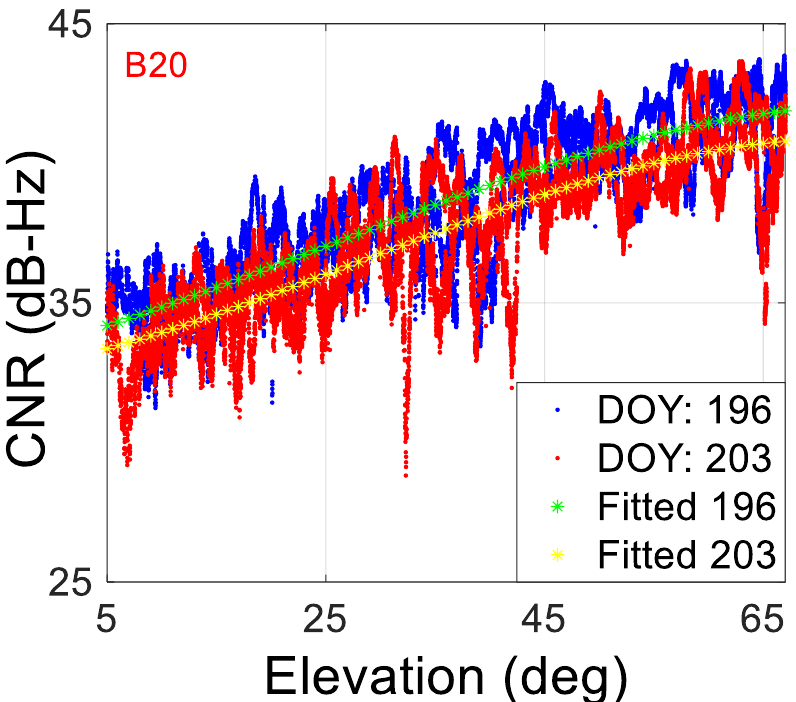
Figure 14. CNR of BDS MEO B20 satellite B1 frequency comparison results with elevation as the horizontal axis. The blue and red dots denote the CNR collected on DOY:196 (no flood) and DOY:203 (with flood), 2021, respectively. The green and yellow lines are the fitted results of CNR on DOY:196 and DOY:203.